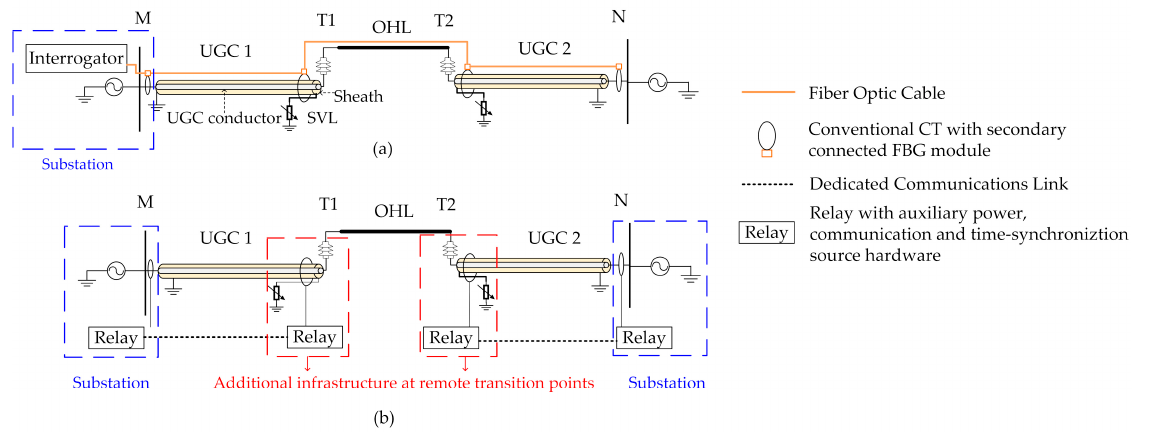
Figure 1. Simple mixed conductor circuit consisting of UGC sections and an OHL section; ( a ) dis- tributed sensing platform; ( b ) traditional differential protection requirements.